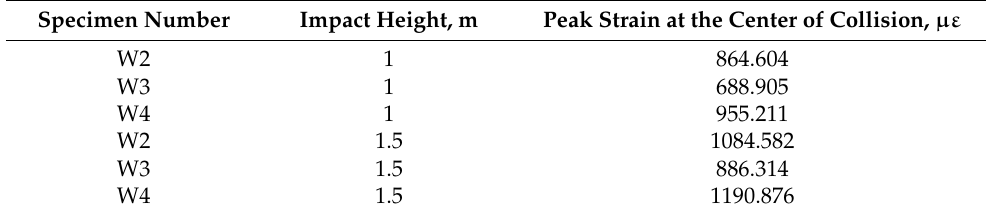
Table 2. Results of peak strain at the center of collision.